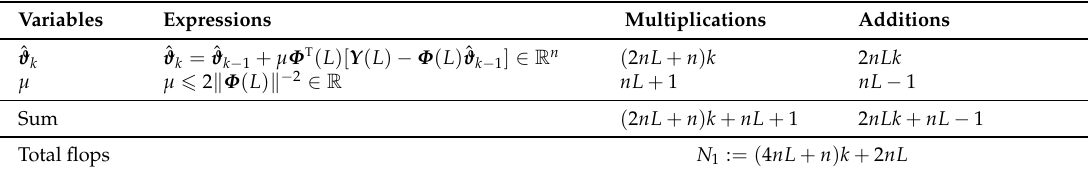
Table 1. The computational efficiency of the gradient-based iterative (GI) algorithm. Variables Expressions